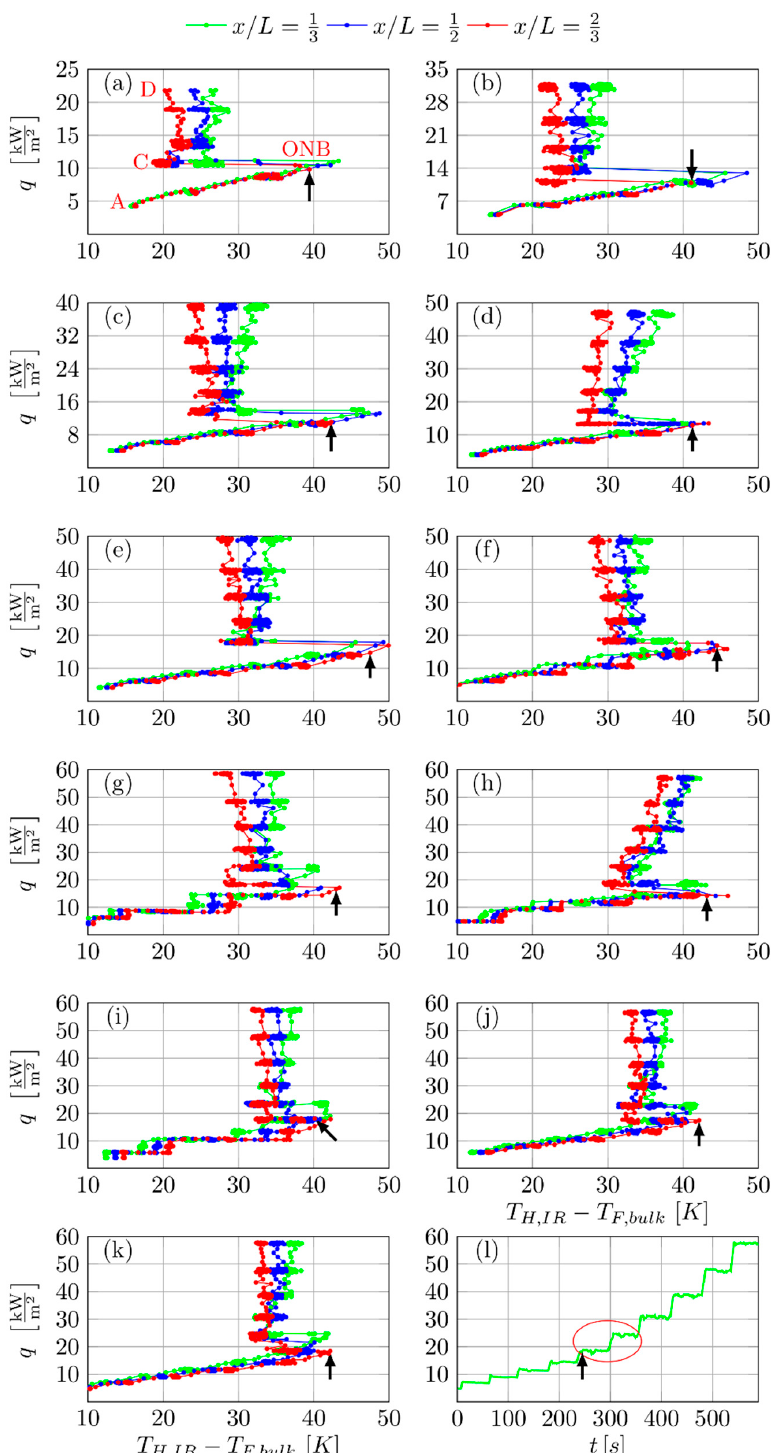
Figure 4. ( a – k ) The boiling curves obtained for selected distances from the minichannel inlet: x/L = 1/3 (green curve), x/L = 1/2 (blue curve) and x/L = 2/3 (red curve), corresponding to following mass flow rates: ( a ) Q m = 5 [ kg/h ] ; ( b ) Q m = 10 [ kg/h ] ; ( c ) Q m = 15 [ kg/h ] ; ( d ) Q m = 20 [ kg/h ] ; ( e ) Q m = 25 [ kg/h ] ; ( f ) Q m = 30 [ kg/h ] ; ( g ) Q m = 35 [ kg/h ] ; ( h ) Q m = 40 [ kg/h ] ; ( i ) Q m = 45 [ kg/h ] ; ( j ) Q m = 50 [ kg/h ] ( k ) Q m = 55 [ kg/h ] ; ( l ) heat flux versus time for the whole experiment, Q m = 55 [ kg/h ] ; other data and parameters of the experimental series are listed in Table 1. The red ellipse indicates subcooled boiling region, whereas black arrows indicate onset of boiling